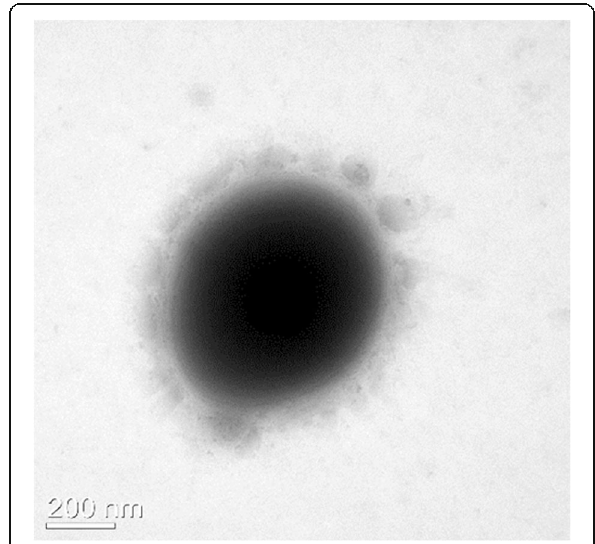
Fig. 1 Transmission electron micrograph showing the general cell morphology of Leuconostoc suionicum DSM 20241 T . The bacterial cells were stained by uranyl acetate and examined using transmission electron microscopy (JEM-1010; JEOL)